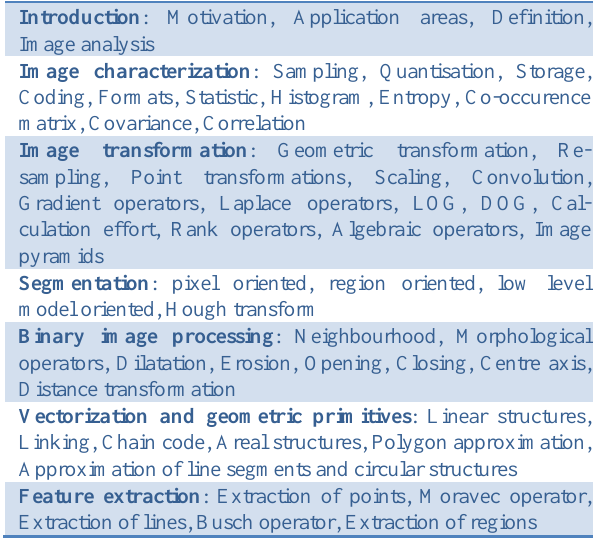
Table 4. Topics in the lecture ‘ Image Processing ’ (1.